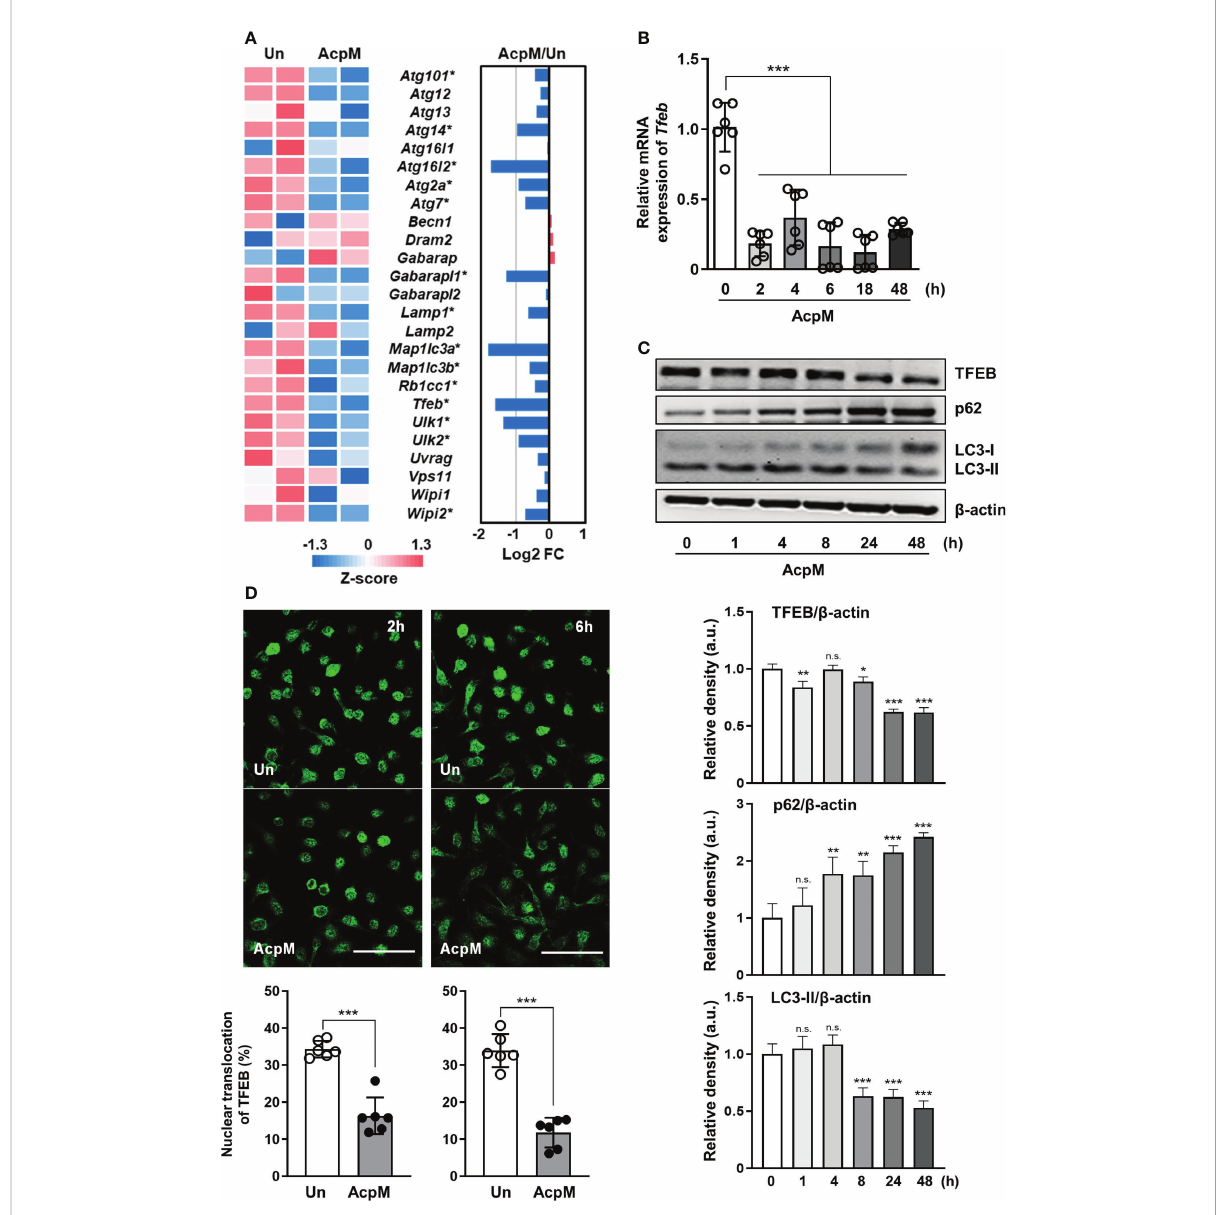
FIGURE 1 AcpM suppresses TFEB expression and its nuclear translocation. (A) A heatmap and a bar graph showing the expression of autophagy-associated genes in the AcpM-treated (AcpM, 10 m g/ml for 18 h) and untreated (Un) BMDMs. The left panel heatmap shows relative expression levels for each gene with Z-scores. The bar graph in the right panel depicts the fold change (FC). Gene names with an asterisk indicate statistical signi fi cance (FDR < 0.01). (B, C) BMDMs were treated with recombinant AcpM (10 m g/ml) for indicated times, and the harvested cells were subjected to either qRT-PCR analysis to measure Tfeb mRNA gene expression (B) or immunoblot analysis to measure TFEB protein expression (C) . One representative image, ( C , upper panel) and the densitometric analysis ( C , lower panel) of immunoblots were presented. (D) BMDMs treated with recombinant AcpM (10 m g/ml) for 2 or 6 h were harvested and stained with TFEB (green). Then the cells were subjected to confocal microscopy. Representative confocal images (Scale bar: 50 m m) from each group were presented. Statistical analysis was determined with an unpaired t -test or one-way ANOVA and presented as means ± SD from at least three independent experiments performed. * p < 0.05; ** p < 0.01; *** p < 0.001. a.u., arbitrary unit; n.s., not signi fi cant; Un, untreated; AcpM,